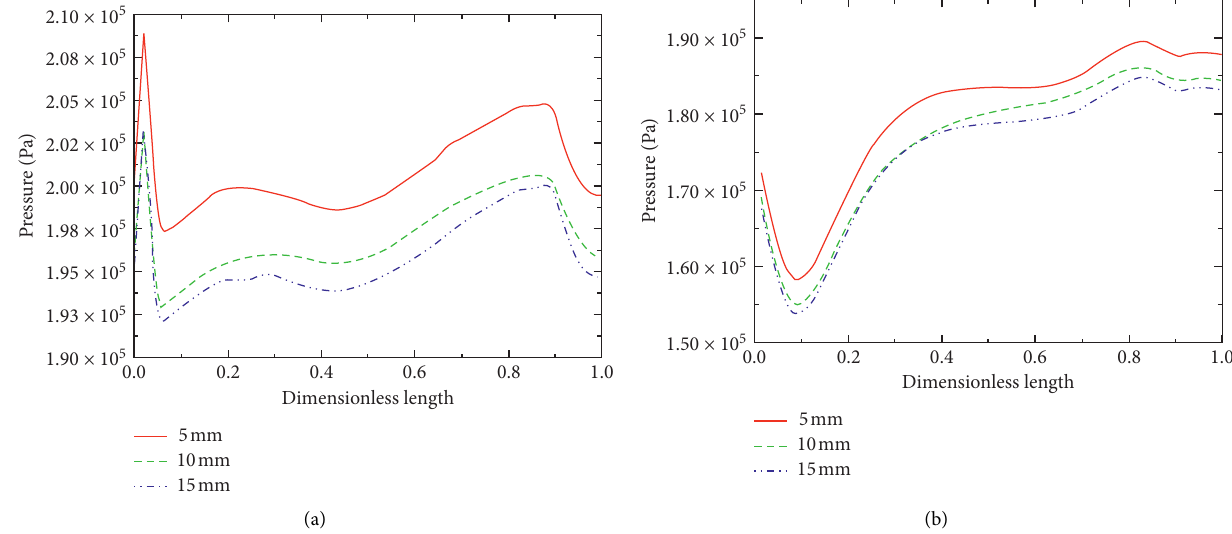
Figure 15: Pressure distribution curves of the guide vane: (a) pressure surface and (b) suction surface.